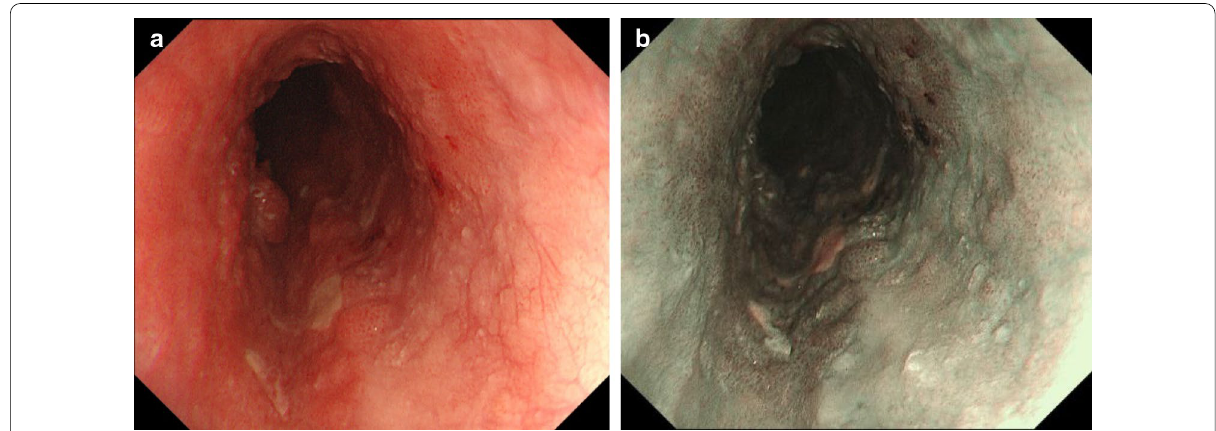
Fig. 3 Patient 2. a Endoscopic findings. The widespread flat lesion in the middle esophagus was detected at 35–40 cm from the upper incisors, and suspected submucosal invasion. b Narrow band